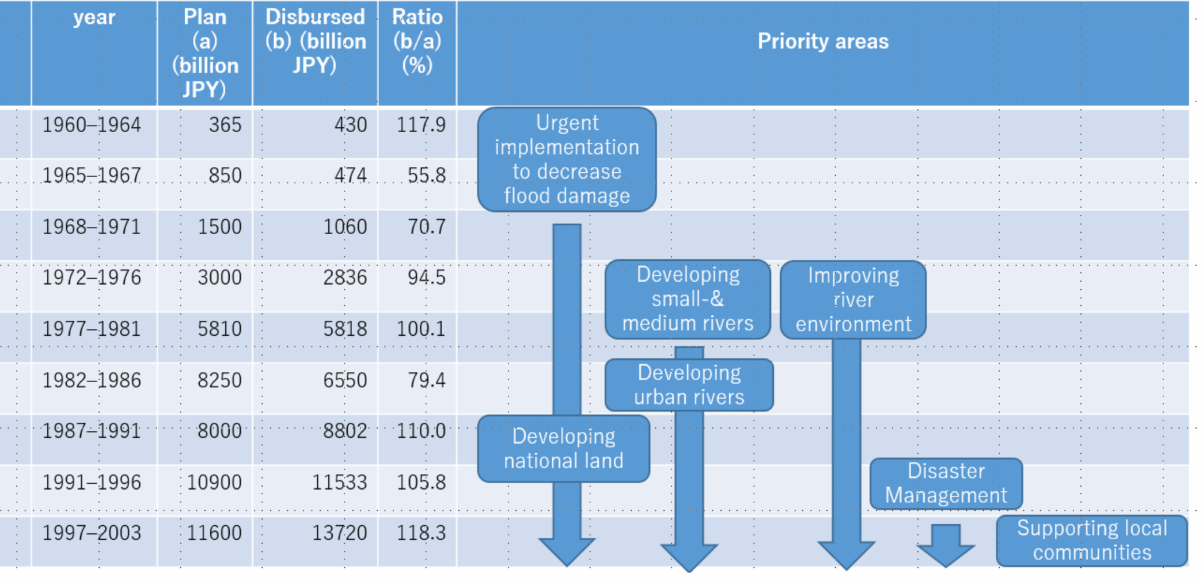
Figure 8. Long-term plans. Source: Modified from Okamura